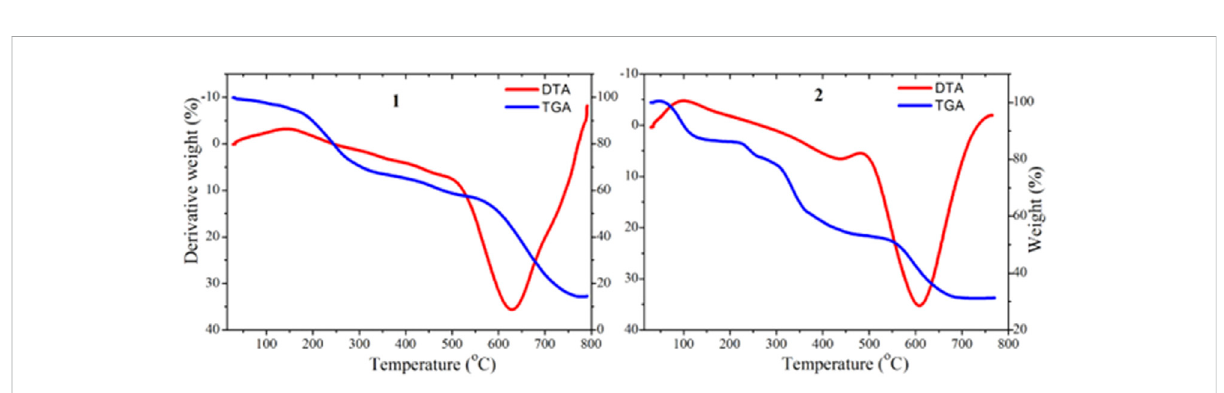
FIGURE 2 TGA (blue) and DTA (red) curves for complexes 1 and 2